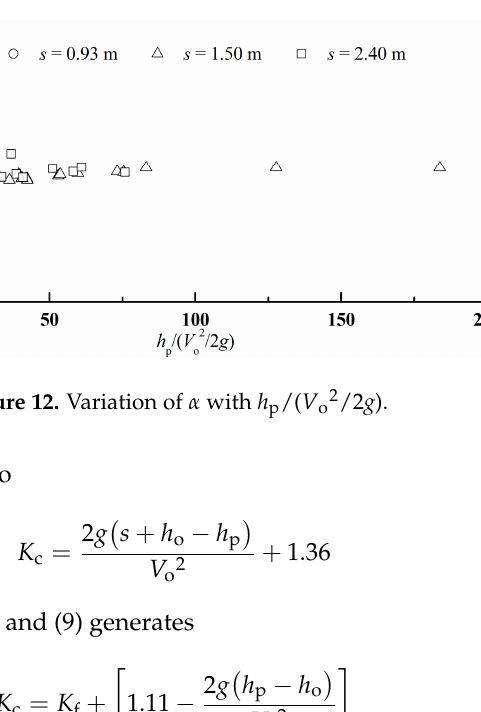
Figure 11. Rating curve between C and h p /( V o2 /2 g ) for ( a ) entire present test range; ( b ) test data for 0 < h p /( V o2 /2 g ) < 50.